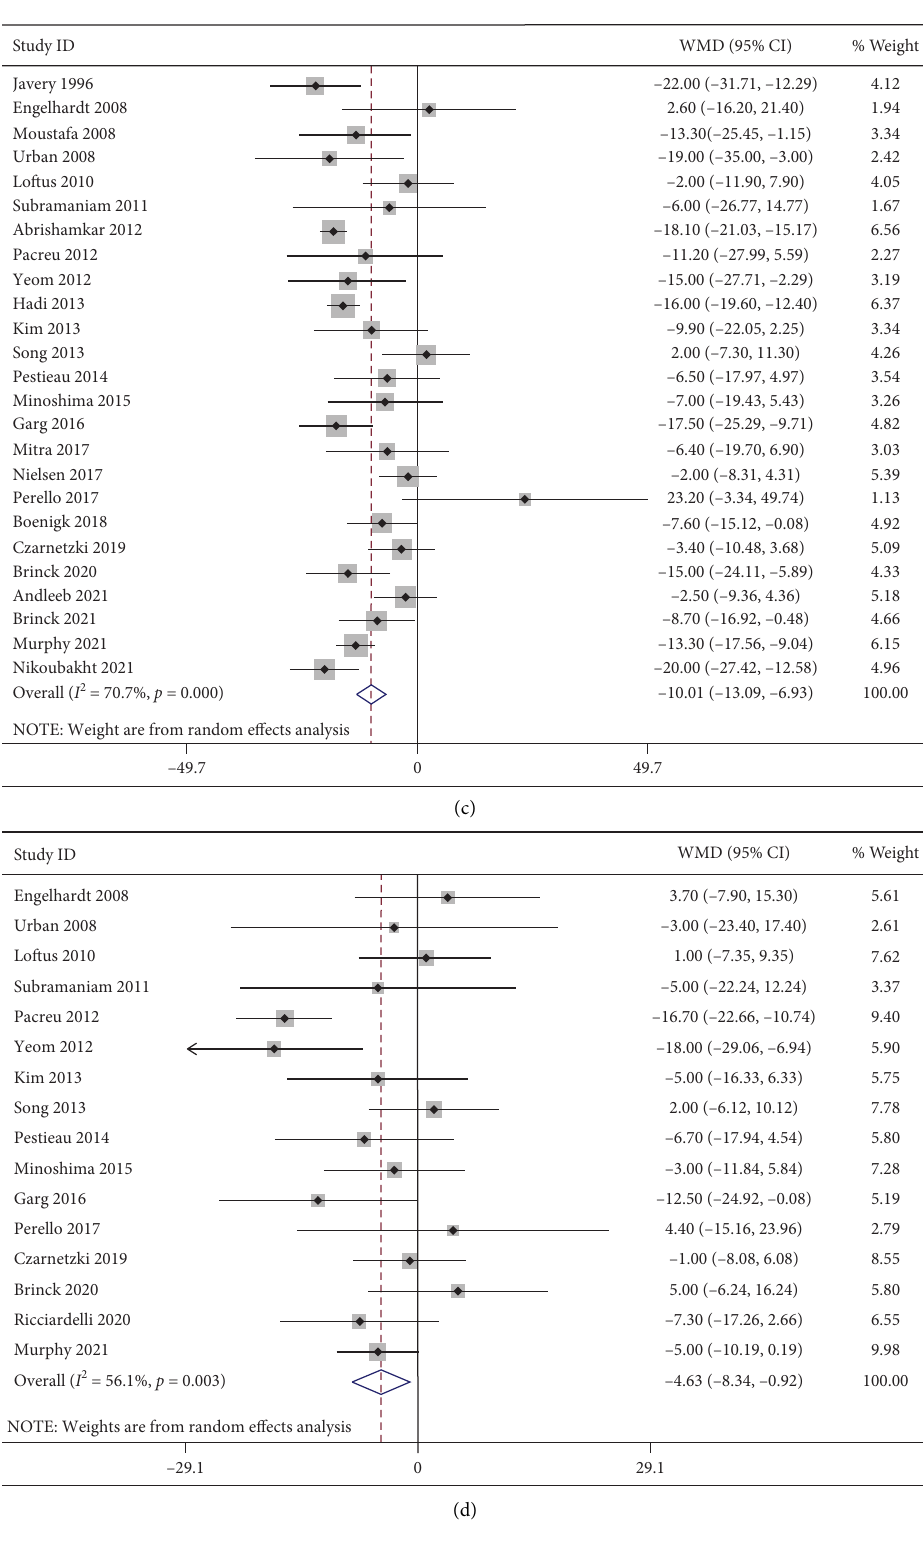
Figure 3: Forest plot of the pain intensity at rest for the ketamine group and control group. (a) 6h; (b) 12h; (c) 24h; (d)